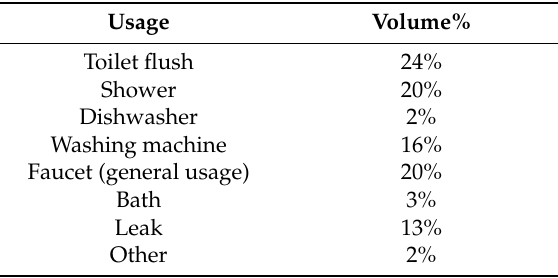
Table 2. Indoor household use by fixture based on a large study involving more than 23,000 homes in North